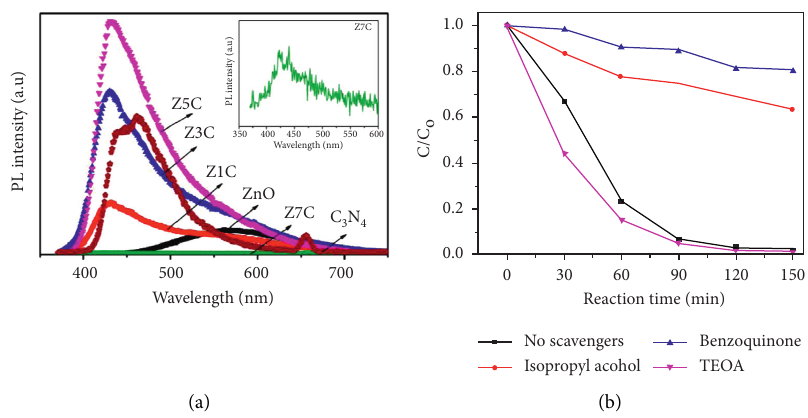
Figure 7: (a) PL spectra of ZnO, g-C 3 N 4 , and g-C 3 N 4 @ZnO composite. (b) Results of active species trapping experiments.